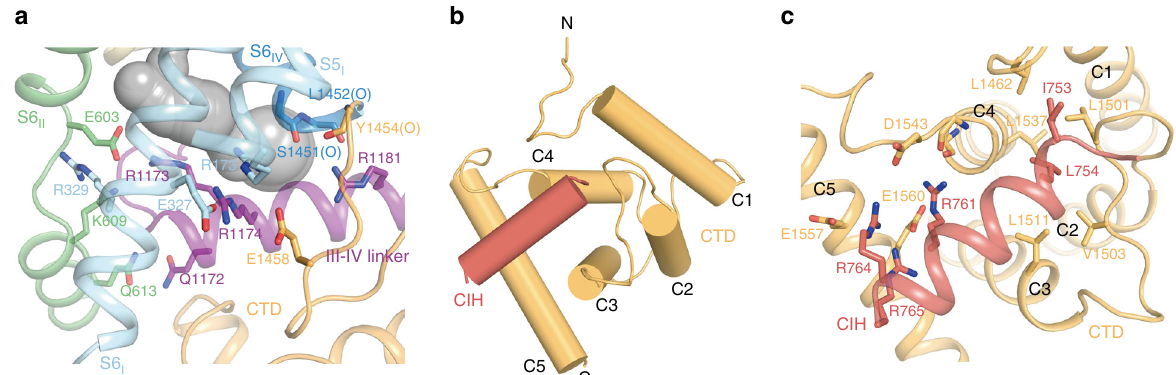
Fig. 5 Structure of NALCN intracellular domains. a III – IV linker has extensive polar interactions with CTD and S6 segments in NALCN. The interacting residues are shown as sticks. The gray surface represents the calculated ion permeation pathway. b Structure of CTD and CIH of NALCN. Helices are shown as cylinders. c Interactions between CTD and CIH of NALCN. The interacting residues are shown as